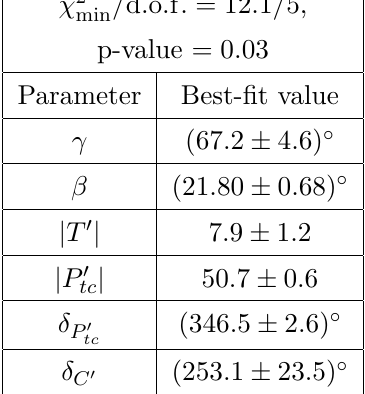
Table 4 . (cid:31) 2 = d : o : f : and best-(cid:12)t values of unknown parameters in amplitudes of eq. (2.1). Con- min straints: B ! (cid:25)K data, measurements of (cid:12) and (cid:13) , theoretical inputs j C 0 =T 0 j = 0 : 2, P 0